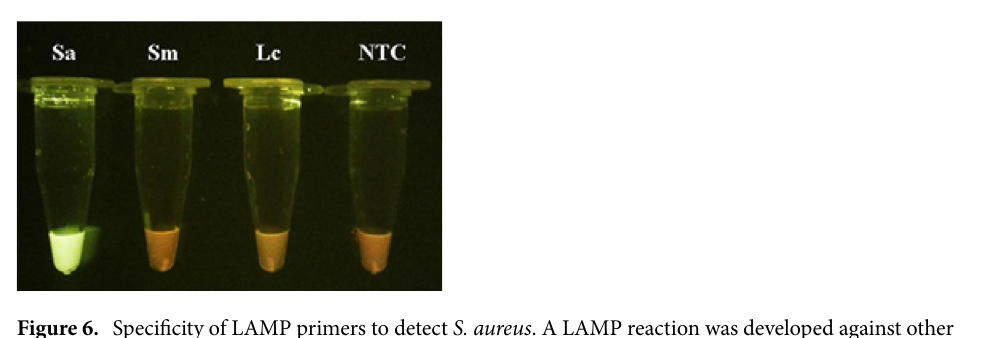
comparison with the no template control (NTC) which had an orange–yellow color (Fig. 4b). On the other hand, reactions with HNB dye show a blue color in the positives and a purple color in the negative reaction (Fig. 4c). Sensitivity on direct detection of S. aureus in inoculated milk samples was observed from 10 9 to 10 4 CFU/mL (Fig. 5). To evaluate the specificity of the primers, DNAs from Serratia marcescens and Lactobacillus casei were employed as a control. Both strains show an orange color in the tube (Fig. 6), these assays prove that in-silico designed primers are targeting S. aureus and there is no cross detection with other bacterial strains. Mobile application for color sensitivity assay detection. Using the proposed smartphone detection system, we analyzed LAMP products with various bacterial load levels. Experiments were performed to measure